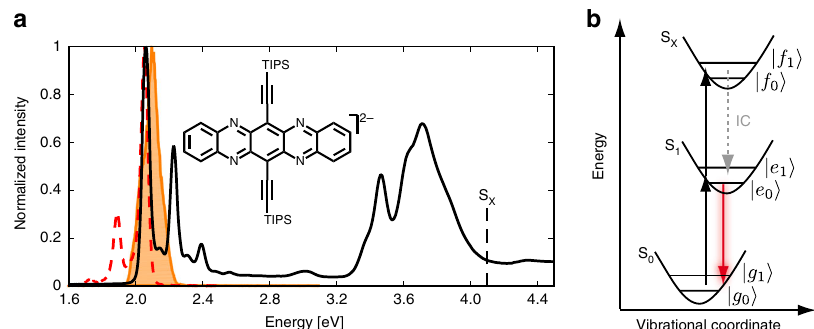
Fig. 2 Sample spectra and energy scheme. a Linear absorption (black, determined via spectroelectrochemistry in THF/N( n -Bu) 4 PF 6 of TIPS – TAP 2 − (molecular structure shown in the inset). The laser spectrum employed in the multidimensional experiment is displayed as an orange shaded area. The emission spectrum of TIPS – TAP 2 − in THF, which was acquired immediately before the multidimensional experiment, is shown as a red dashed line. Absorption and emission spectra are normalized to their respective maximum value. The black dashed line at 4.1 eV marks the energy of the doubly excited state S x . b Energy-level scheme used for interpreting the 3D spectra with the dashed gray arrow denoting internal conversion (IC) and the red arrow the observed fl